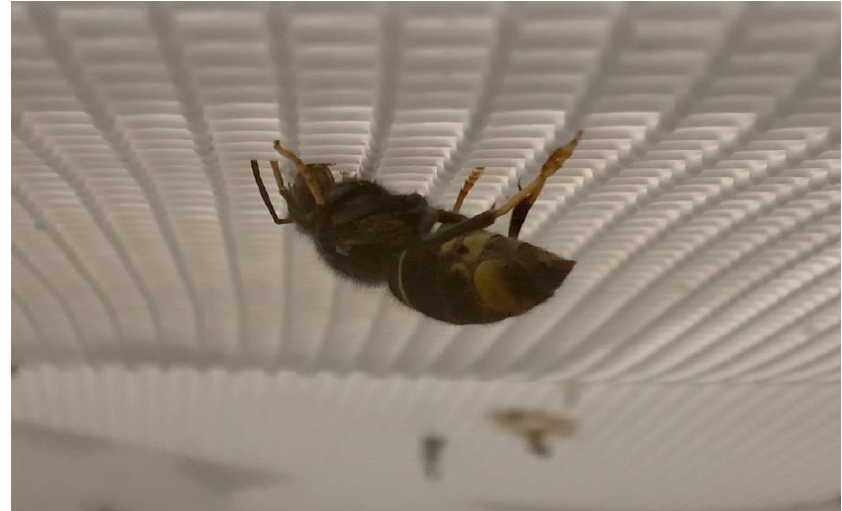
Figure 7. Vespa velutina hornet taking food from the impregnated paper on the